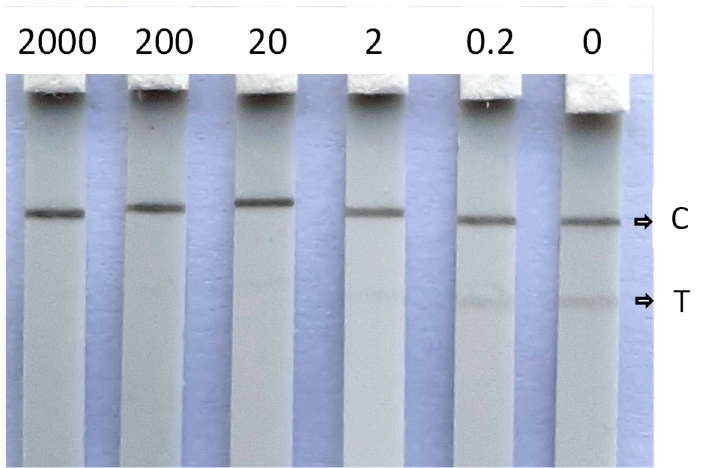
Figure 6. Visual detection of CHLP (µg/L) in fortified diluted fresh lime tree honey with C indicating the control line and T indicating the test line.